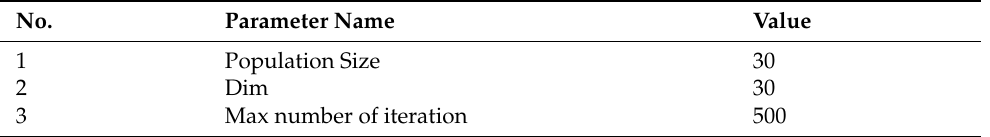
Table 1. Experiment parameter